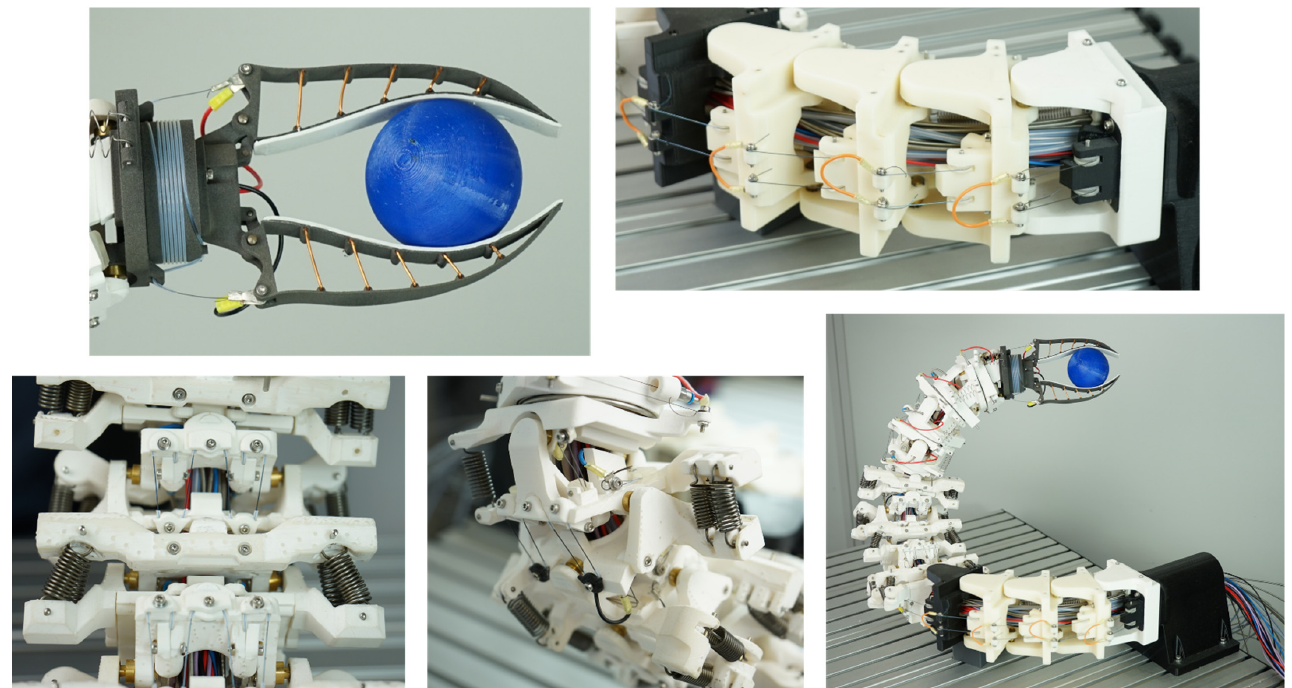
Figure 9. Prototype of the biomimetic owl neck spine and fundamentally different joint assemblies.